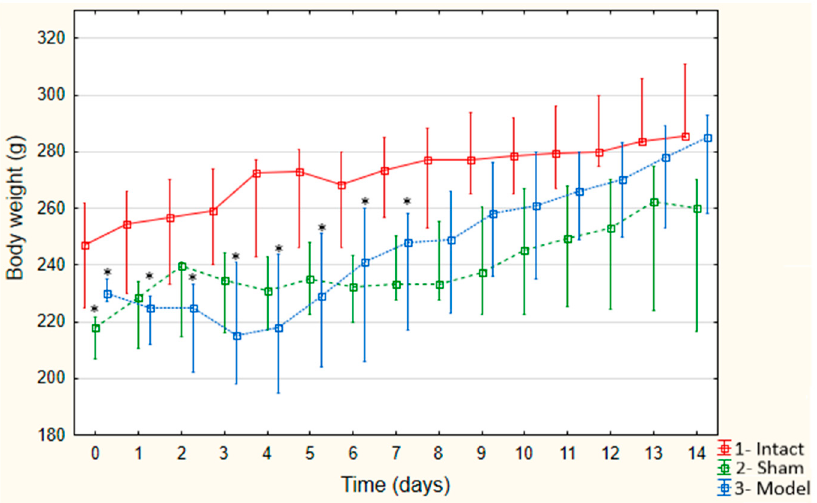
Figure 3. Mass dynamics during the experiment (* p < 0.05 in comparison to Group 1—Intact ani- mals).